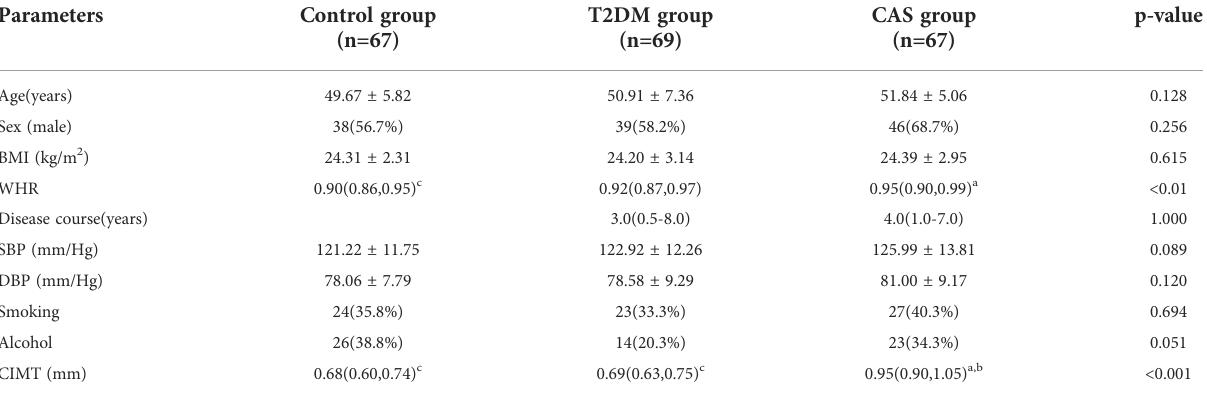
TABLE 1 General information of the Control group, the T2DM group, and the CAS group.